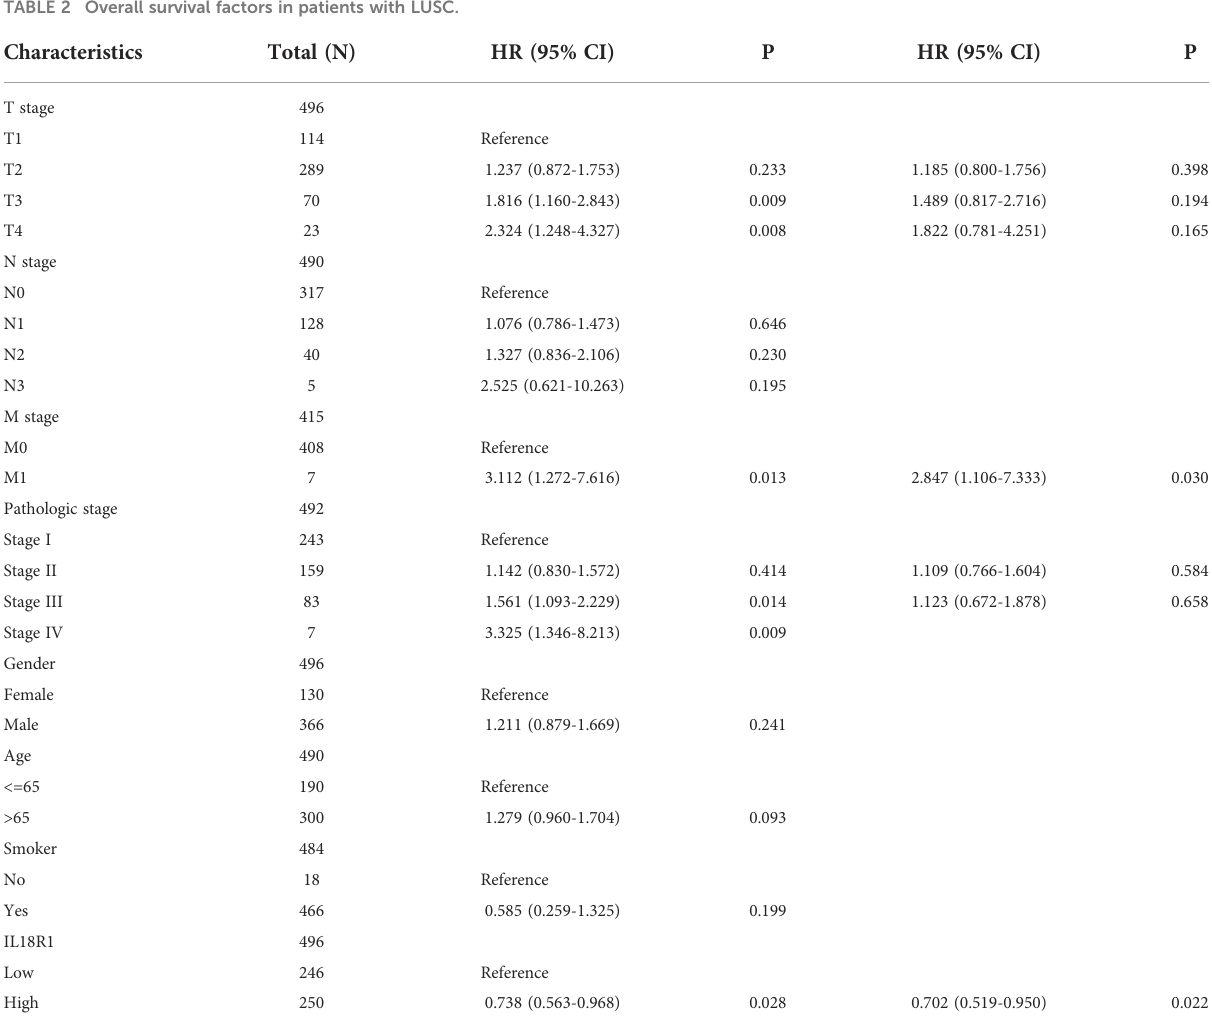
TABLE 2 Overall survival factors in patients with LUSC.